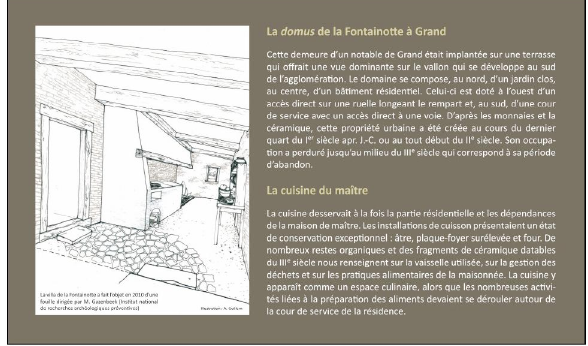
Figure 5. Final outcome, integration of the image in an exhibition’s